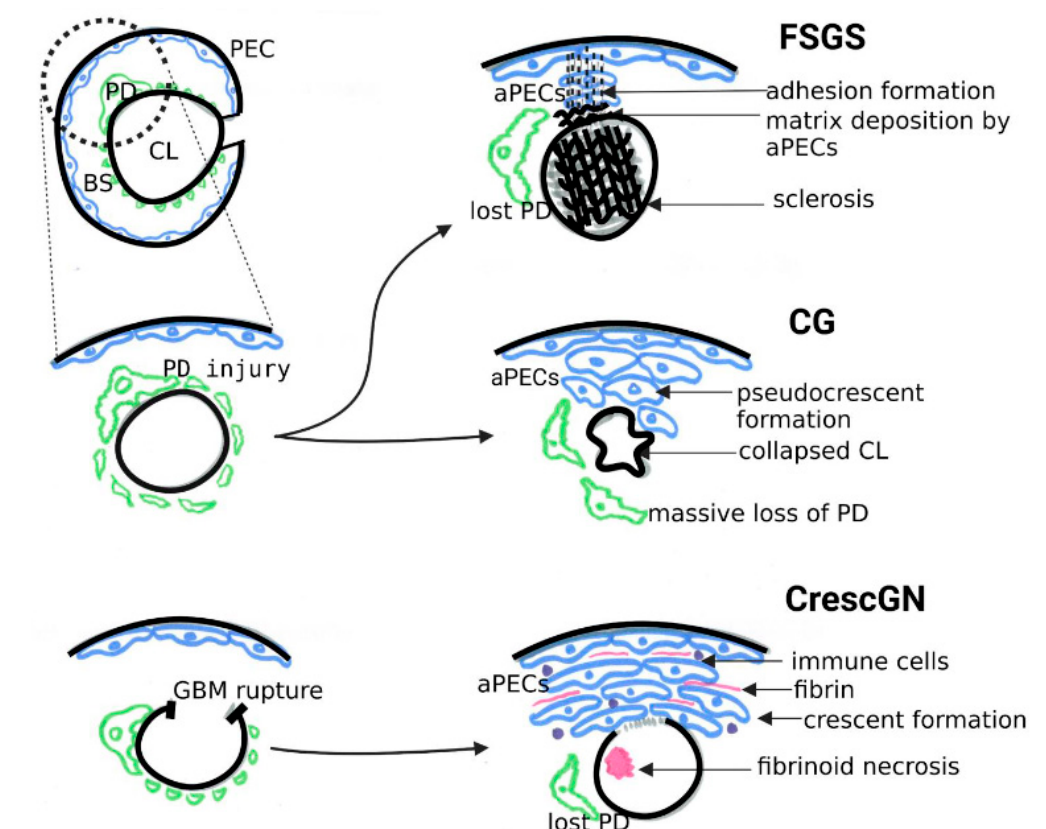
Figure 2. Schematic representation of pathogenesis of three diseases characterized by parietal epithelial cell activation- classical focal segmental glomerulosclerosis, collapsing glomerulopathy, and crescentic glomerulonephritis. FSGS—focal segmental glomerulosclerosis; CG—collapsing glomerulopathy; CrescGN—crescentic glomerulonephritis; PEC—parietal epithelial cell; PD—podocyte; GBM—glomerular basement membrane; BS—Bowman’s space; CL—capillary lumen; aPECs—activated parietal epithelial cells.